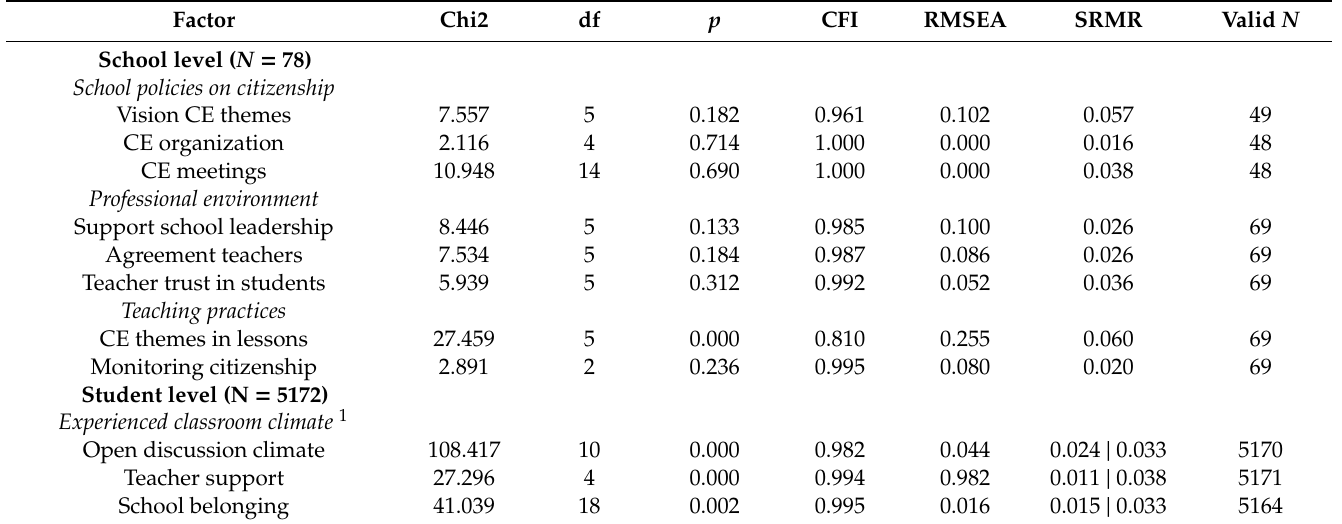
Table 1. Model fit estimates of citizenship education factor